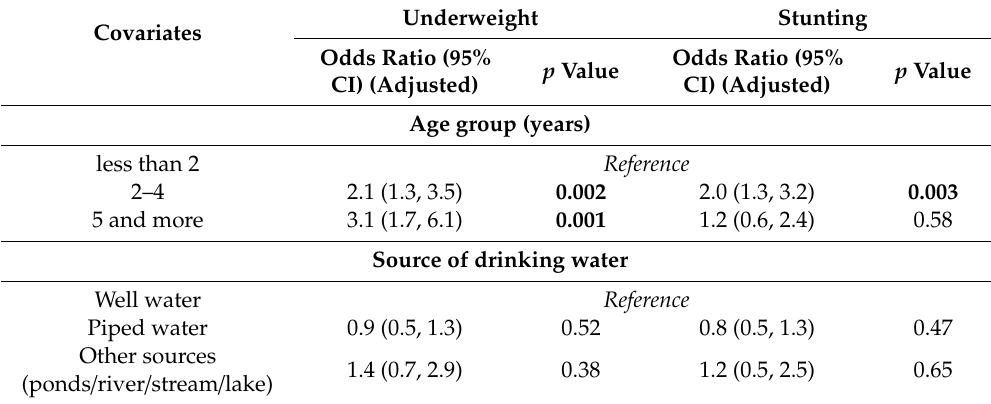
Table 5. Factors associated with underweight and stunting among children with CP in Vietnam (unadjusted